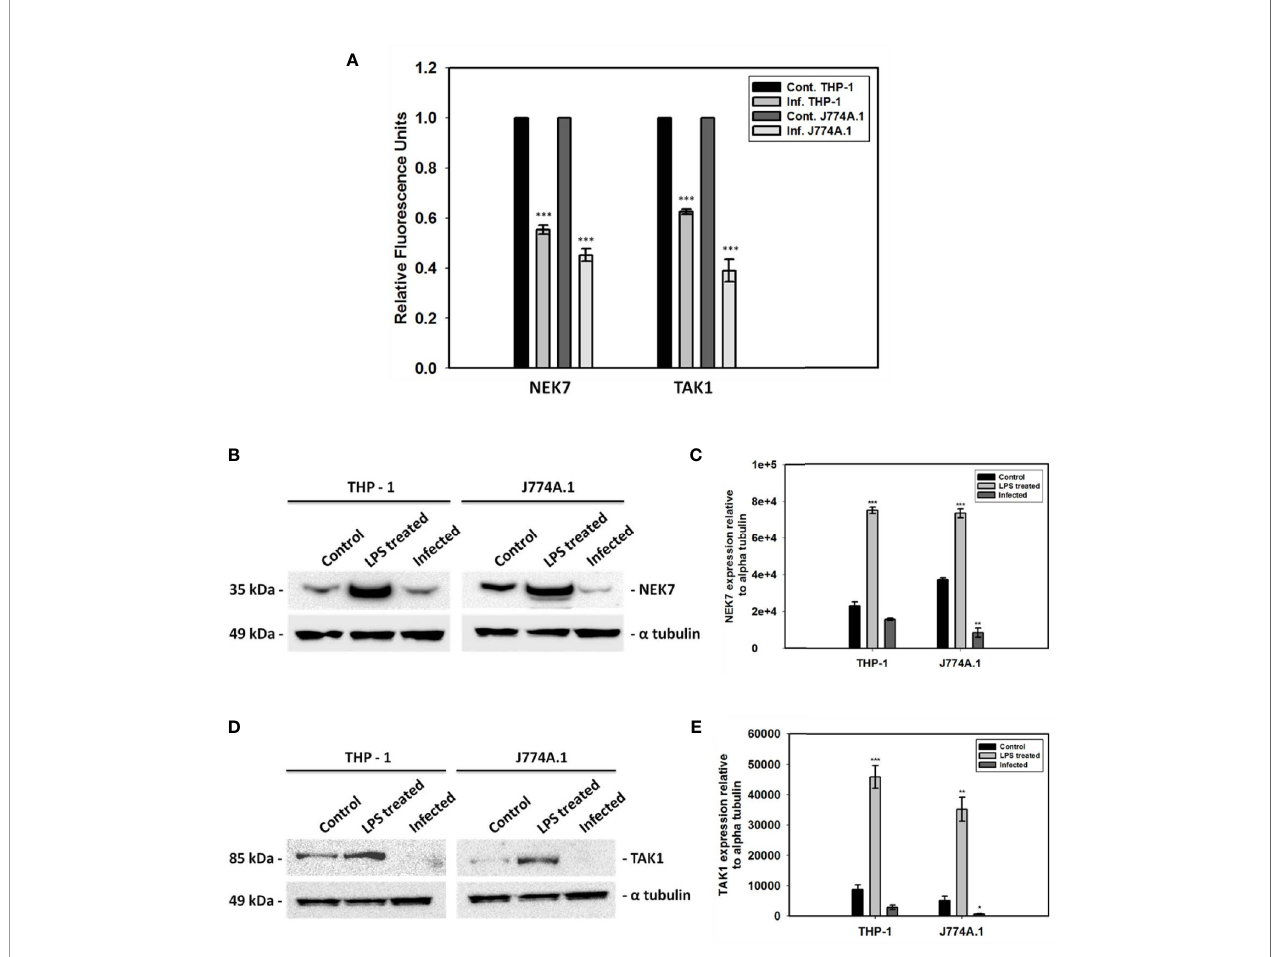
FIGURE 1 | Gene expression analyses and immunoblotting of NEK7 and TAK1. (A) Transcriptional analyses of two kinases, nek7 and tak1 involved in the PTMs of NLRP3 in fl ammasome have been shown in both THP-1 and J774A.1 cells infected with promastigotes at MOI of 1:5 for 24 h; Decrease in (B, C) NEK7 expression and (D, E) TAK1 expression was found in both THP-1 and J774A.1 cells infected with promastigotes at MOI of 1:5 for 24 h. Bacterial LPS treated cells were used as positive controls for the experiment. (Note: n = 3, where n represents three different independent experimental replicates for all the experiments; * denotes p < 0.05, ** denotes p < 0.005, *** denotes p < how BLIMP-1 regulates the control of cell proliferation and survival through the negative regulation of p53 at the transcriptional level (Yan et al., 2007).